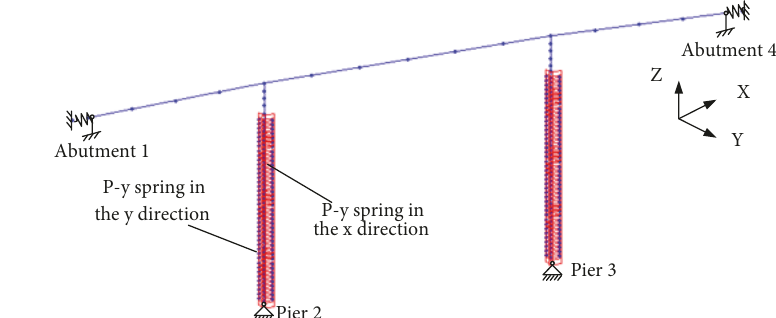
Figure 7: Global view of the bridge model.